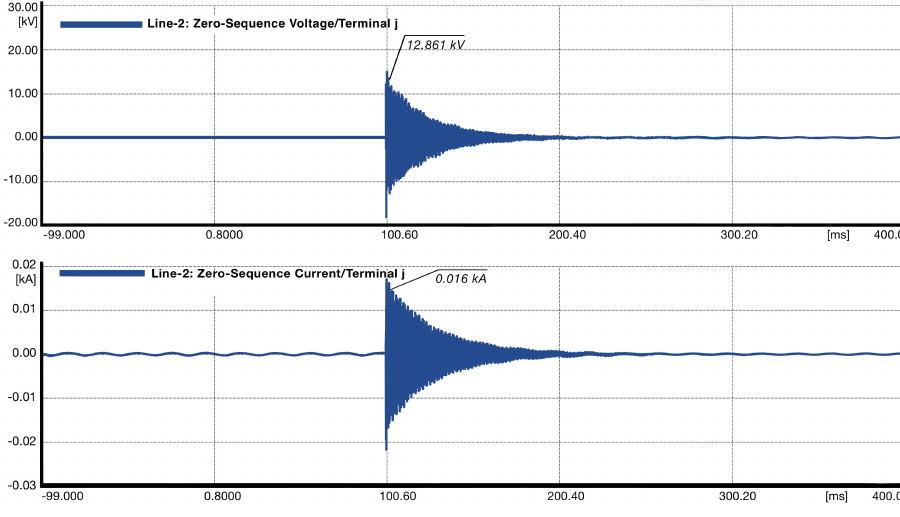
Figure 8. Zero-sequence voltage and current for phase–ground fault.